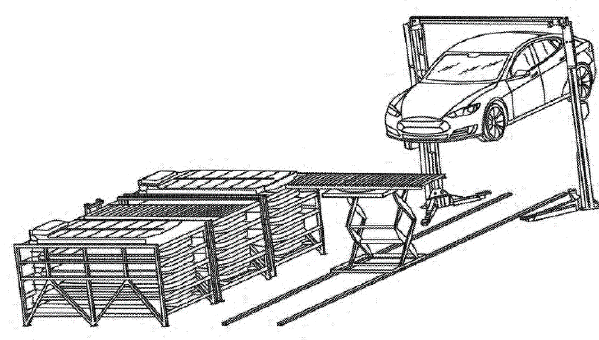
Figure 6. Fully charged battery packs on a rack ready for battery swaps [15].